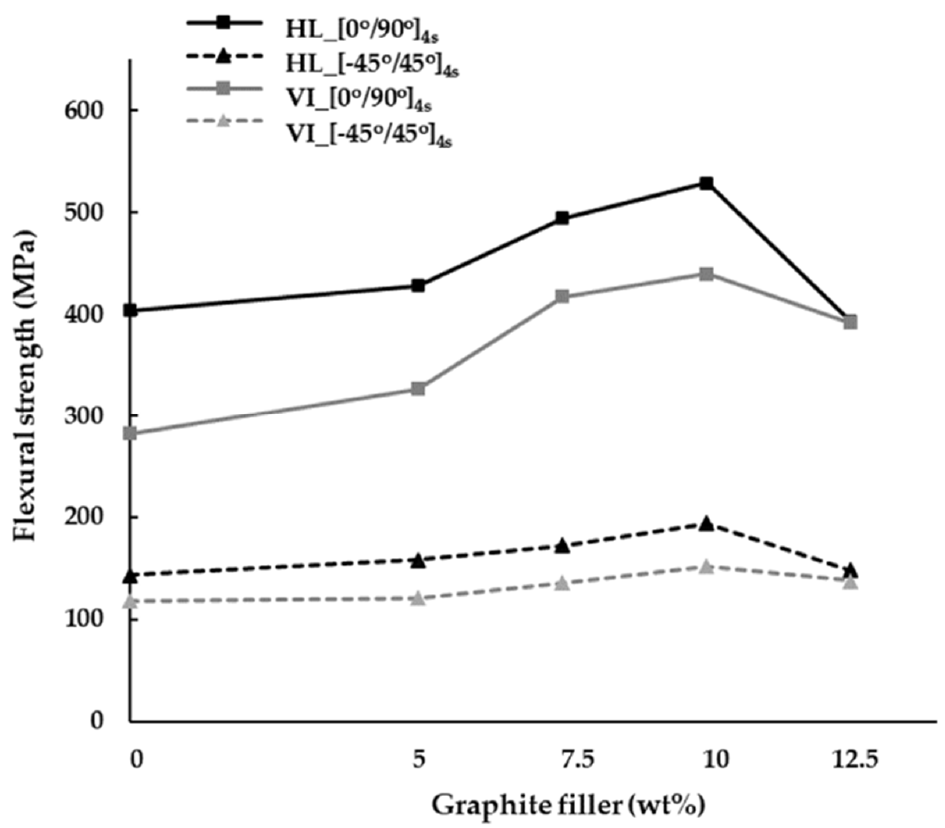
Figure 10. The flexural strength of different manufacturing processes.